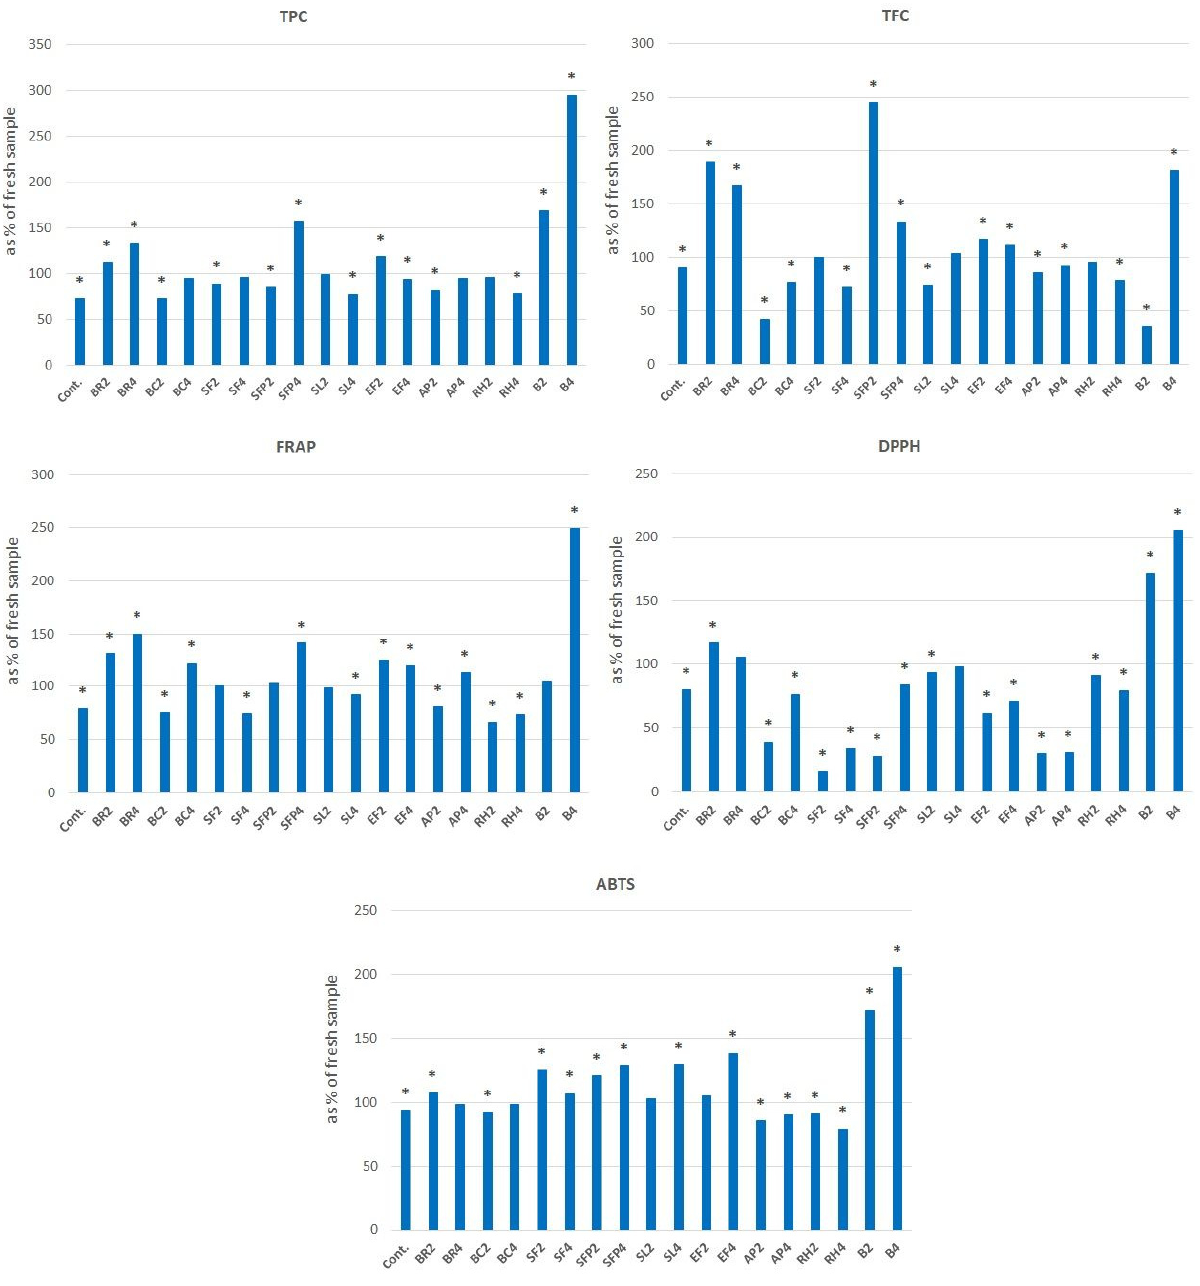
Figure 1. Percentage changes in the tested parameter related to antioxidant activity determined after three months of storage of flavored honeys in relation to the initial value (fresh sample). Cont.—